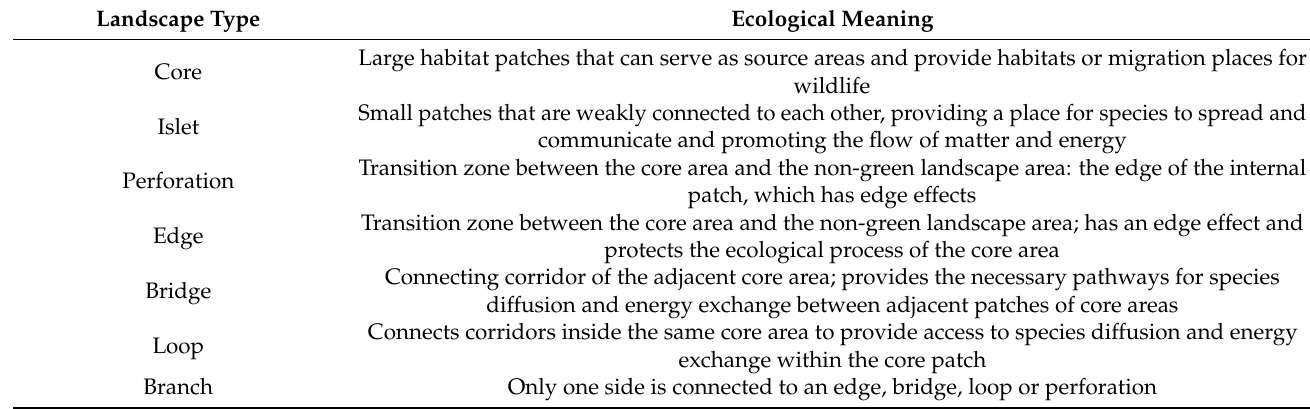
Table 4. Landscape types of MSPA and their meanings.